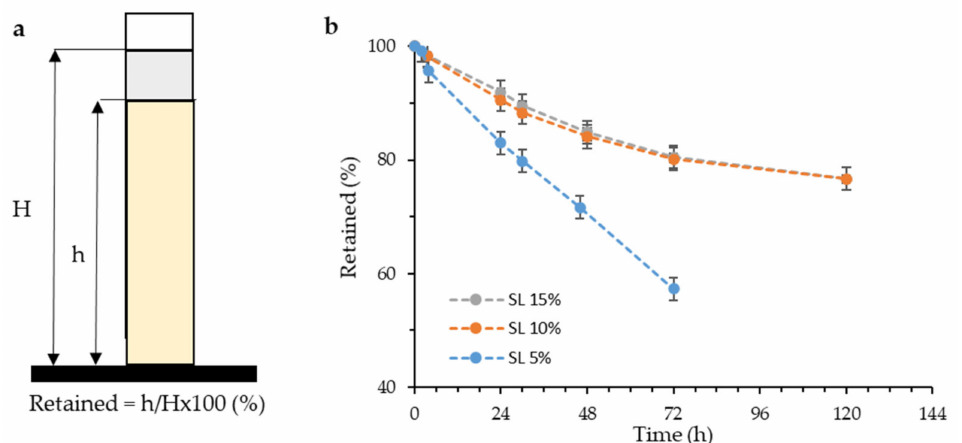
Figure 7. ( a ) Sedimentation rate calculation principle and ( b ) retained rate for reinforced resins indicating the sedimentation rate of the different developed